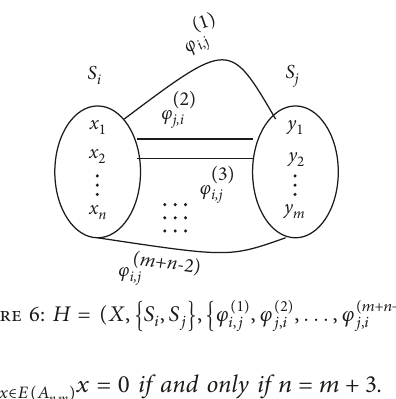
, S , φ ( 2 ) , . .. , φ ( m + n − 2 ) 􏽮 􏽯 , φ ( 1 ) 􏽮 􏽯 ) i j i,j j,i j,i